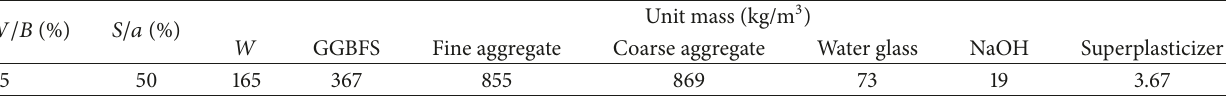
Table 1: Mix proportions of AAS concrete.